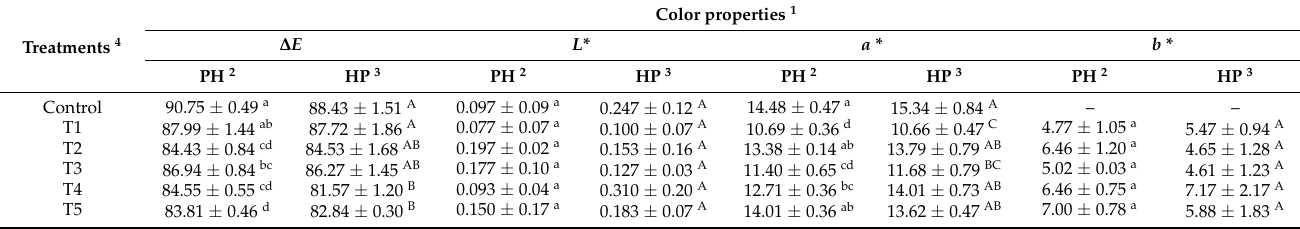
1 : Mean ± standard deviation of all ice cream treatments with the CIE L*a*b* color measurement system. 2 : a–d denote the level of significance at p < 0.05 within the process variation of PH; the same letter indicates that the treatments are not significantly different from each other. 3 : A–C denote the level of significance at p < 0.05 within HP; the same letter indicates that the treatments are not significantly different from each other. 4 : See Table 1 for the definitions of treatment abbreviations (F1–F5). – Data is not